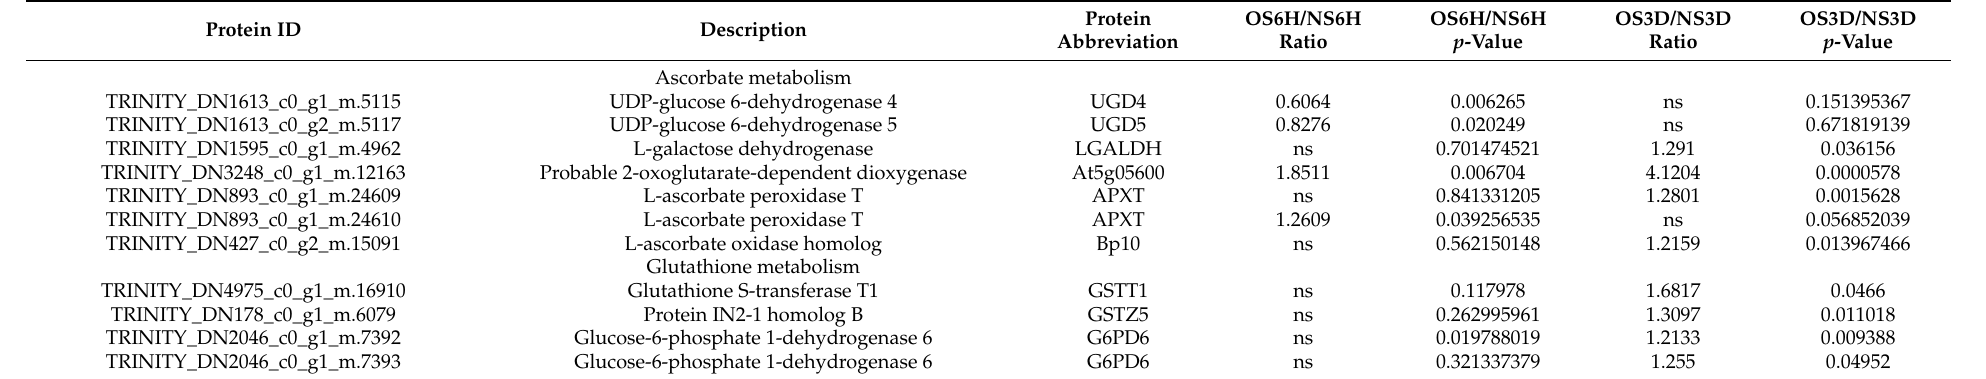
Table 4. DAPs are involved in glutathione and ascorbate